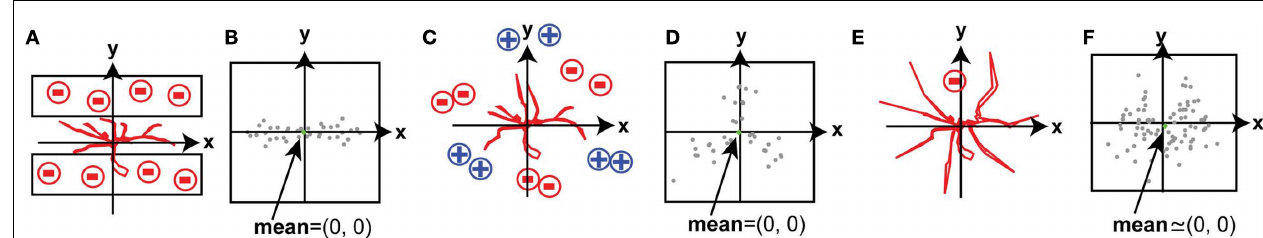
change in branch tip positions induced by the experimental conditions in (A,C,E) respectively, plotted on an x , y coordinate, where the origin (0,0) indicates no displacement. (B) Shows displacements along the x axis, but little change along the y axis under conditions in which extending neurites are sandwiched by repellents.The spatial map in (C) shows displacements of individual branch tips in three directions, but no mean directional change, in response to a complex distribution of growth promoting and growth inhibiting cues. (E) Shows avoidance of a small sub-region, but very small mean directional